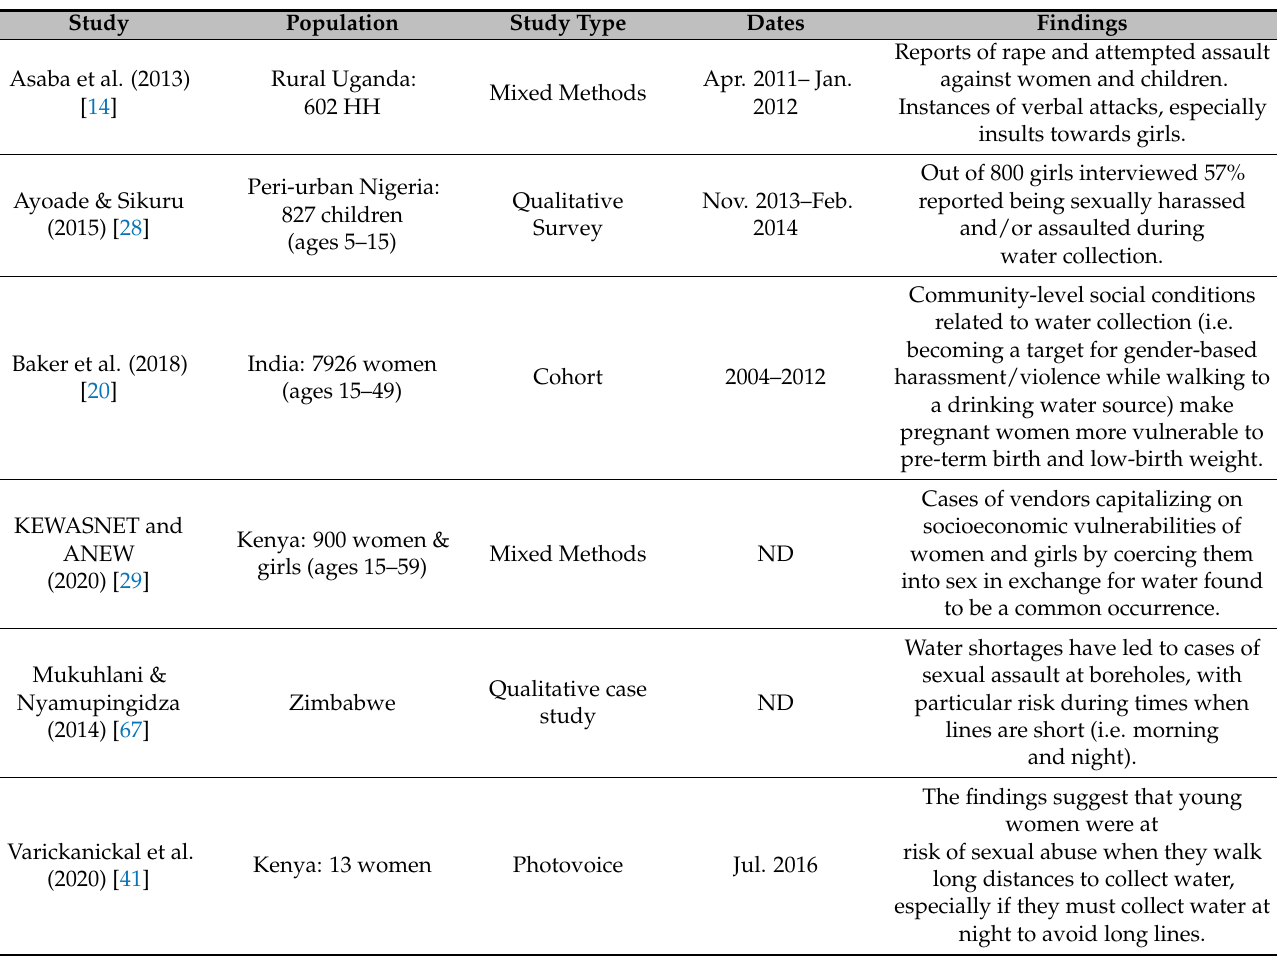
Table A3. Gender-based violence associated with water and solid fuel collection and